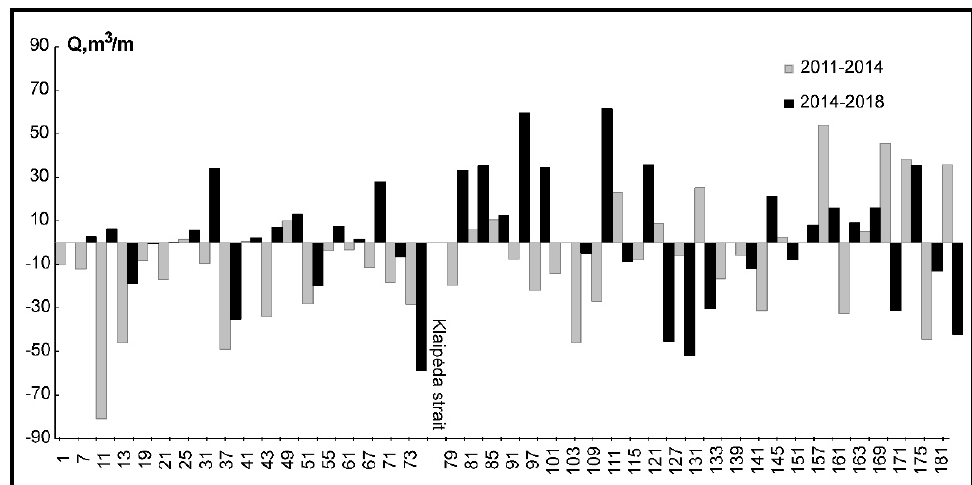
Figure 4. The changes in beach sediment volume ( Q , m 3 /m) distribution along the coast of the south-eastern Baltic Sea coast (Lithuania) in 2011, 2014, and 2018.